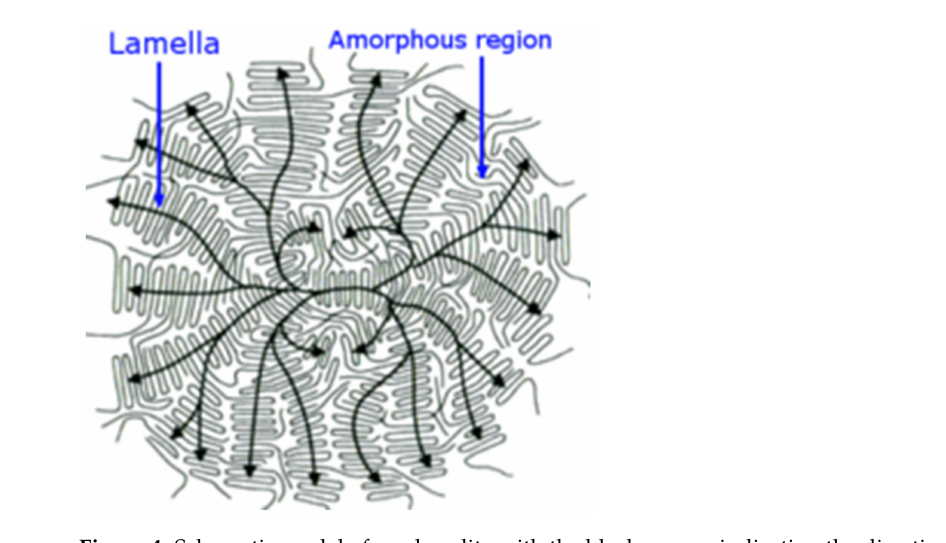
Figure 4. Schematic model of a spherulite with the black arrows indicating the direction of molecu- lar